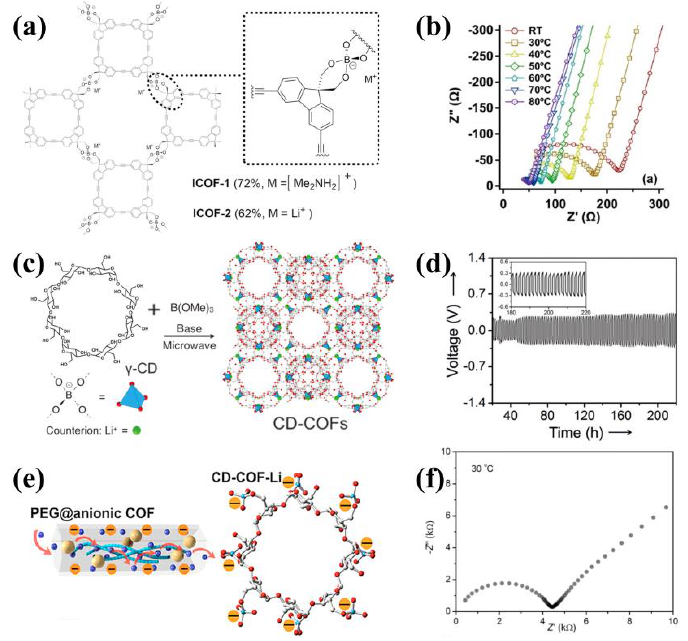
Figure 11. ( a ) Structure of ICOF − 1 and ICOF − 2; ( b ) Nyquist plot of ICOF − 2. Reproduced with permission from Ref. [65], Copyright (2015), John Wiley and Sons; ( c ) Synthesis of CD − COFs; ( d ) Stripping/plating test of Li/CD − COF − Li@LiPF 6 − EC − DMC/Li at a current density of 0.085 mA cm − 2 .Reproduced with permission from Ref. [66], Copyright (2017), John Wiley and Sons; ( e ) Schematic illustrations of Li + transport in CD − COF − Li; ( f ) The EIS spectra of PEG − Li + @CD − COF − Li at 30 °C . Reproduced with permission from Ref. [48], Copyright (2018), American Chemical Society.